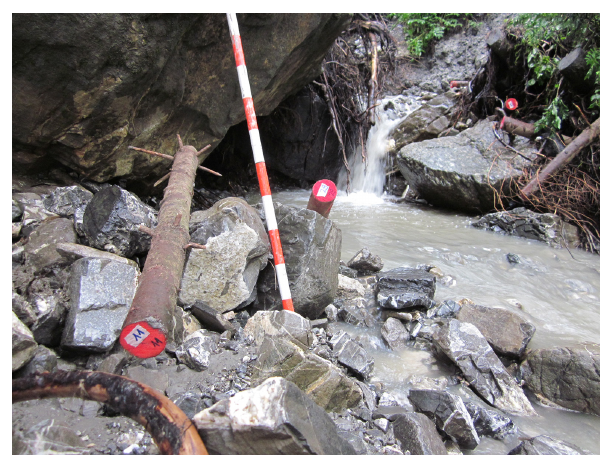
Figure 2. Tracer log with length 100cm lying loose on the chan- nel surface in the foreground. Other tracer logs are visible in the